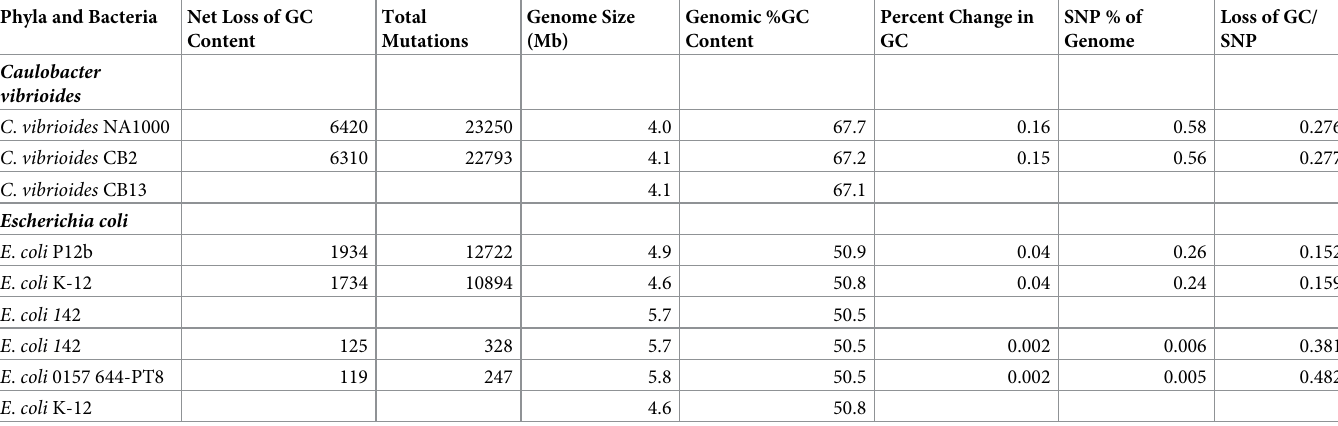
Table 2. Loss of GC content in C . vibrioides and E . coli